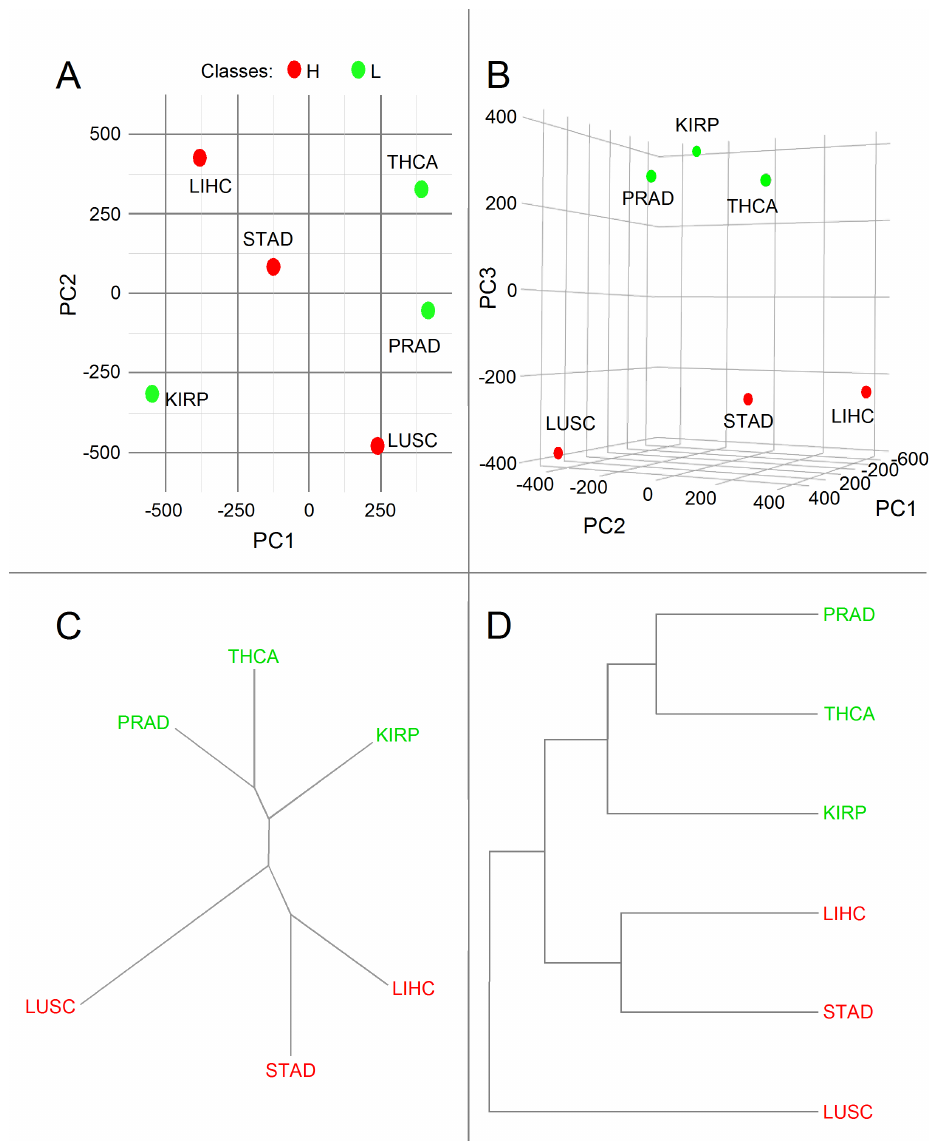
Figure 4. Bidimensional PCs ( A ) and three-dimensional PCs ( B ). Principal component analysis (PCA) representations of the variance of upregulated genes frequency considering the eight pathways and cancer type and dendrograms of hierarchical clustering of the PC3 components showing a clear divi- sion of cancer types into H (red) and L (green) classes. Unrooted ( C ) and rooted ( D )